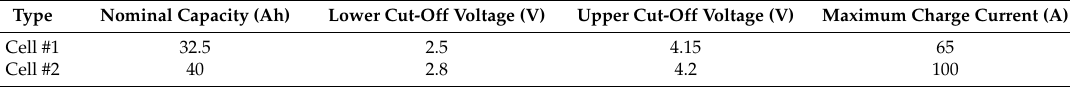
Table 2. Main parameters of experimental lithium-ion batteries (LIBs).